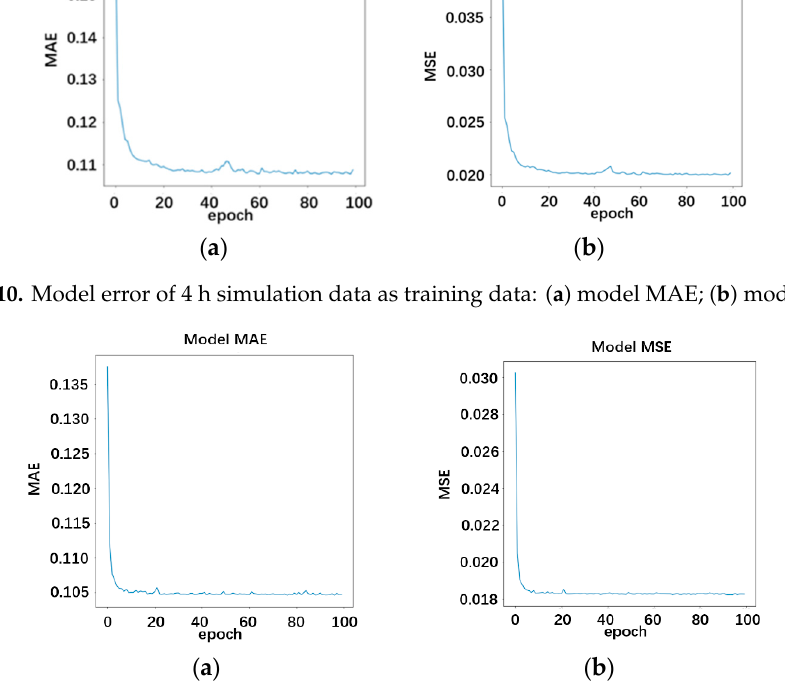
Figure 11. Model error of 6 h simulation data as training data: ( a ) model MAE; ( b ) model MSE.